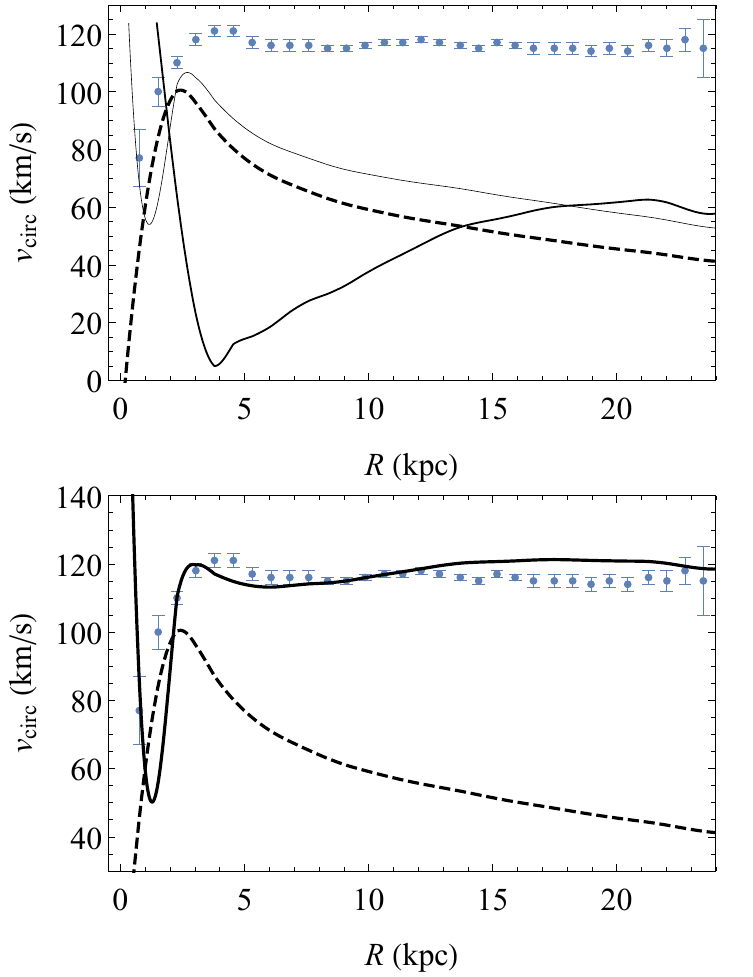
Figure 5 . Comparison of the data points of NGC6503 with the n = 3 rotation curve of the theory T v with weighted derivatives in the limit of weak fractional corrections with a data-based matter density profile for α = 1 (Einstein’s theory, dashed curve), α = 1 . 1 , 1 . 6 and R = 5 kpc (top panel, ∗ increasing thickness) or α = 4 / 3 and R = 3 . 5 kpc (bottom ∗